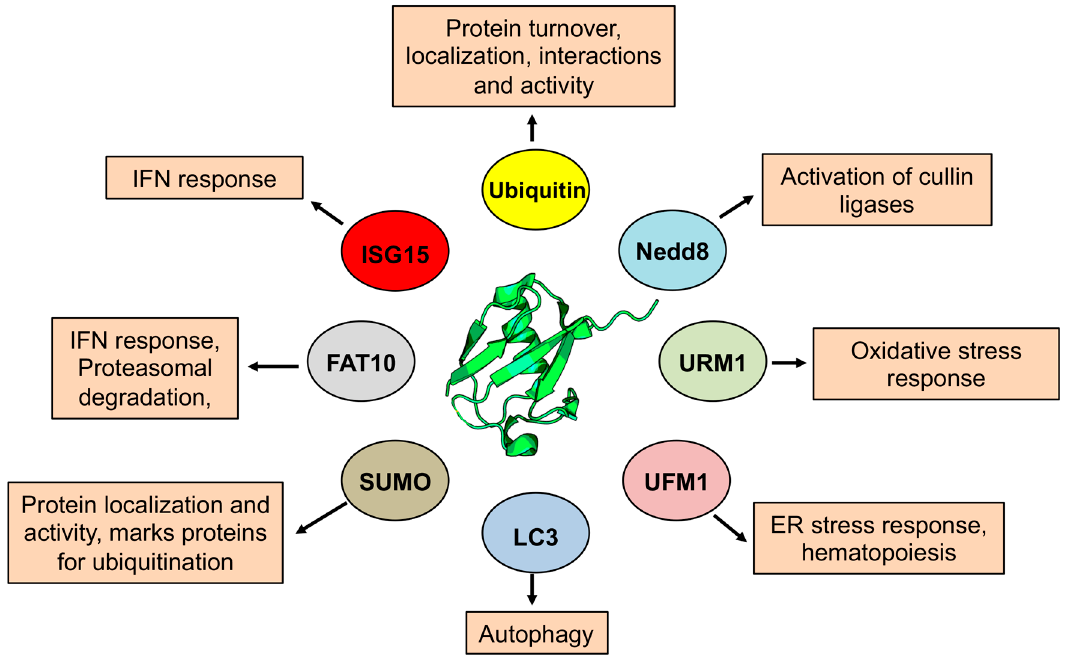
Figure 2. Diverse functions of the UbLs. The UbLs are involved in a large variety of cellular processes, with each UbL targeting distinct functions depending on the range of modified substrates. di ff erent types of ubiquitination regulate endocytosis protein tra ffi cking, transcription and